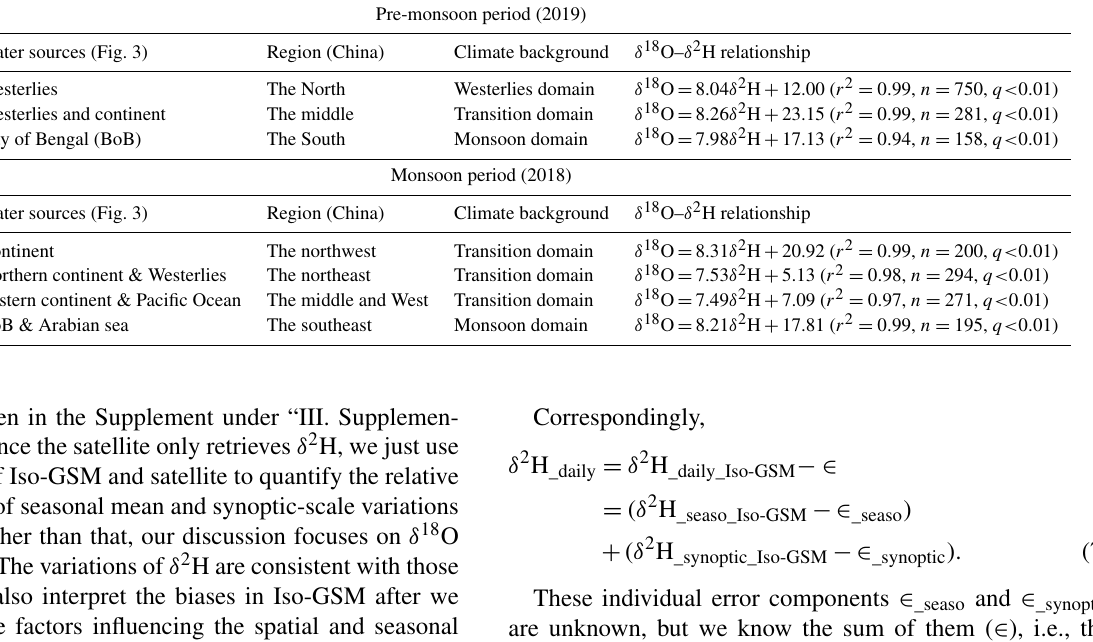
Table 1. The dividing of the study zones based on moisture sources and corresponding vapor δ 18 O– δ 2 H